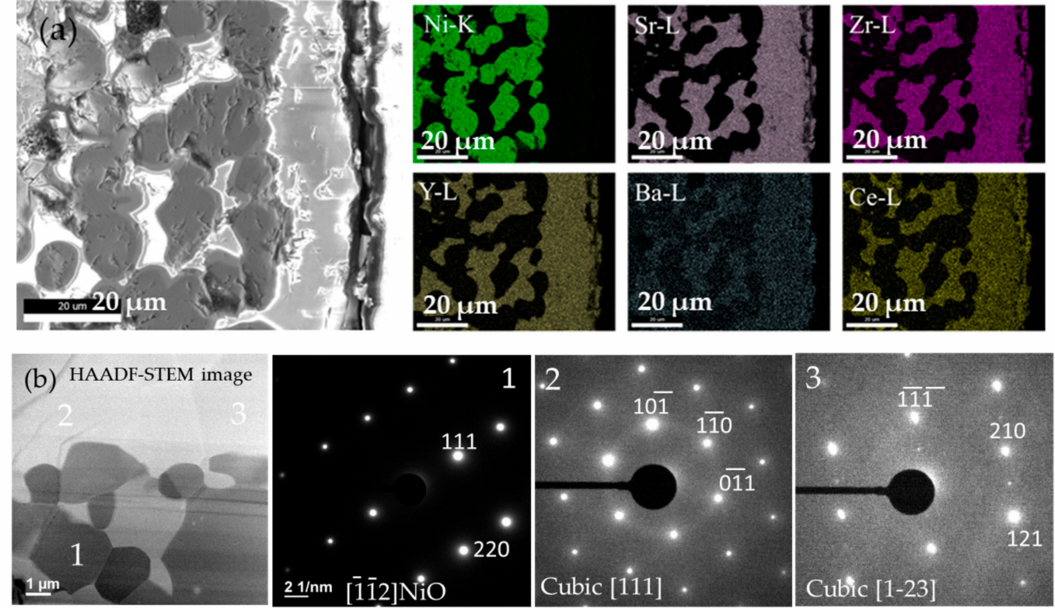
Figure 10. ( a ) SEM and STEM analysis of NiO-BZCY(54) 8 / 9 2 / NiO-SZCY541 / BZCY(54) 8 / 9 2 half-cell with corresponding EDS maps of Ni, Sr, Zr, Y, Ba, Ce. ( b ) High-angle annular dark-field (HAADF) micrograph of the BZCY(54) 8 / 9 2 / NiO-BZCY(54) 8 / 9 2 support substrate interface and selected-area electron di ff